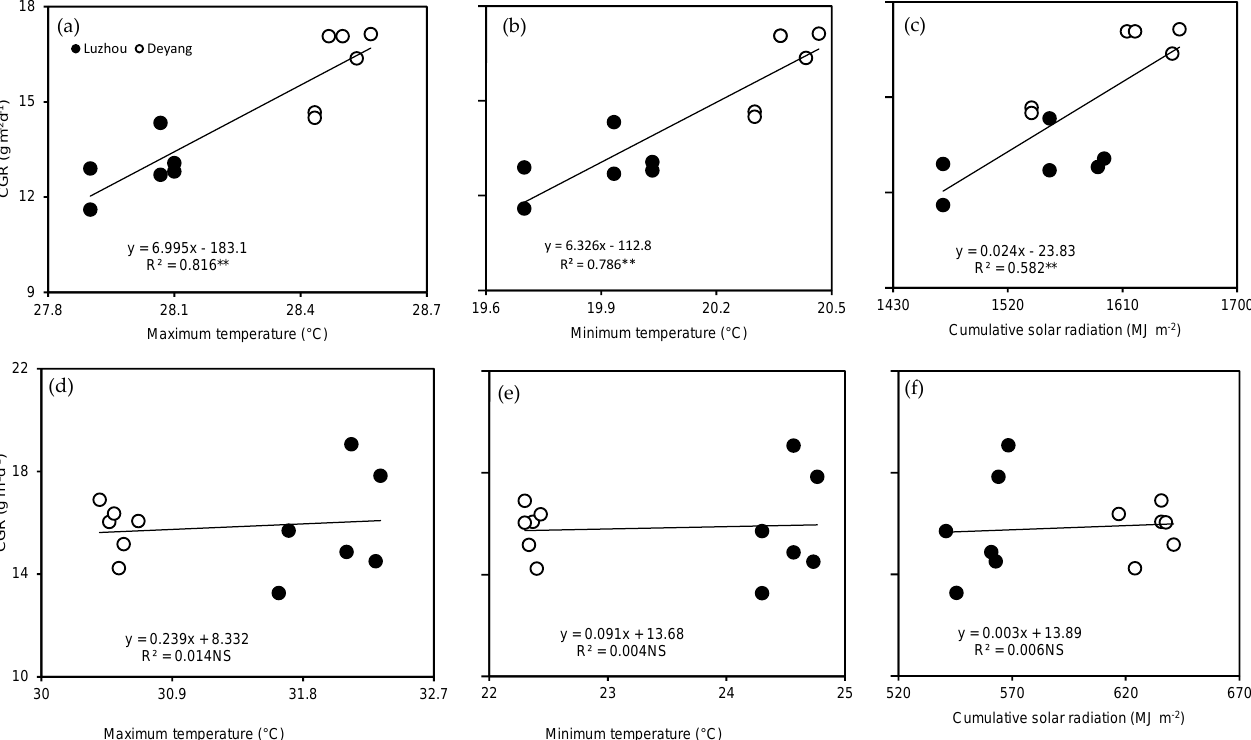
Figure 7. Relationships between crop growth rate (CGR, g m − 2 d − 1 ) and maximum temperature ( a ), minimum temperature ( b ), and solar radiation ( c ) during the pre-heading periods and between crop growth rate (CGR, g m − 2 d − 1 ) and maximum temperature ( d ), minimum temperature ( e ), and solar radiation ( f ) during the post-heading periods for the six rice cultivars over three years. ‘**’ denotes a significant relationship at the 0.01 probability level. ‘ NS ’ denotes a non-significant relationship at the 0.05 probability level.